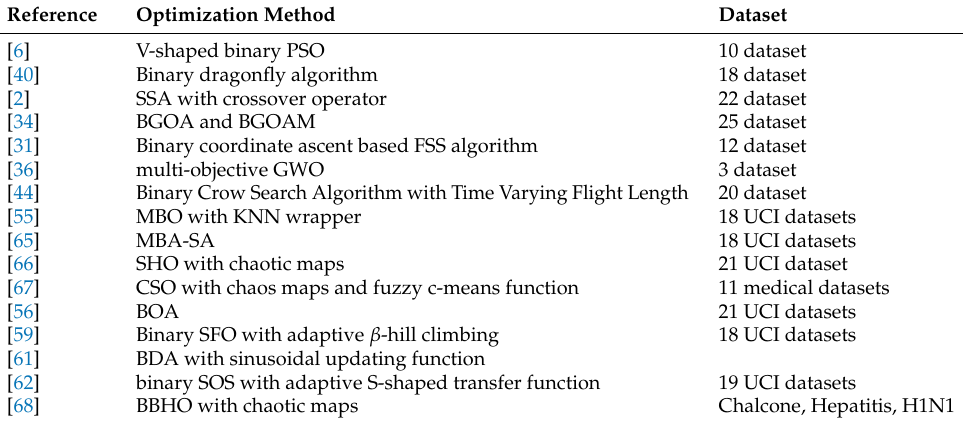
Table 1. Summary of related works for feature